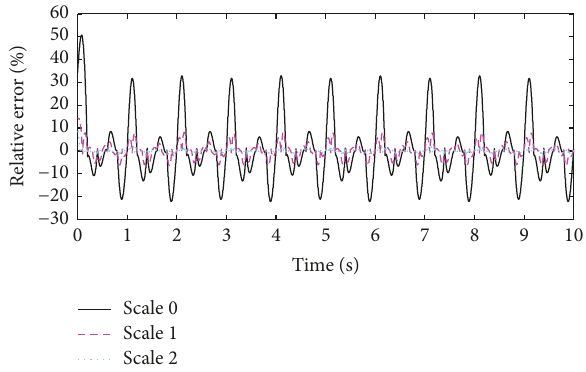
Figure 13: The reconstructed error in Case